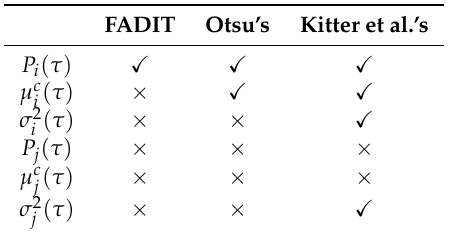
Table 1. Comparison of FADIT, Otsu’s, Kitter et al.’s algorithms, “ (cid:88) " denotes the corresponding item is necessary to be calculated while “ × " denotes